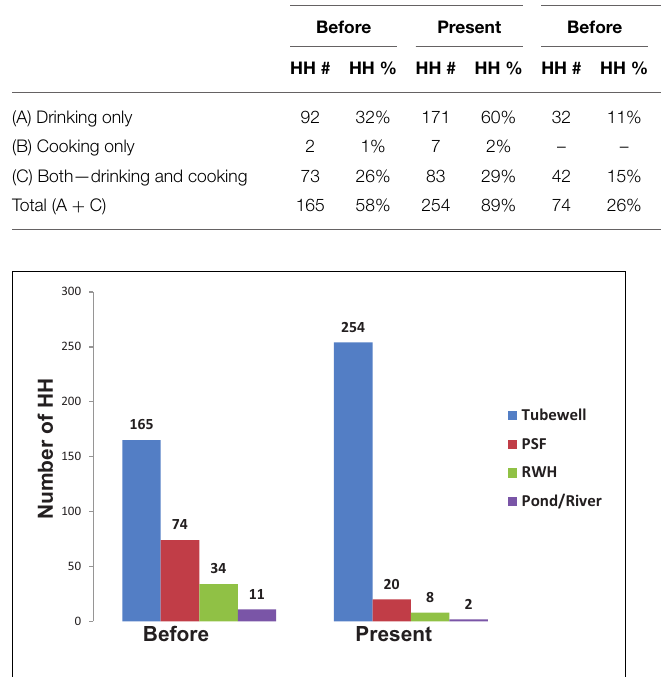
FIGURE 8 | Change in drinking water preference.